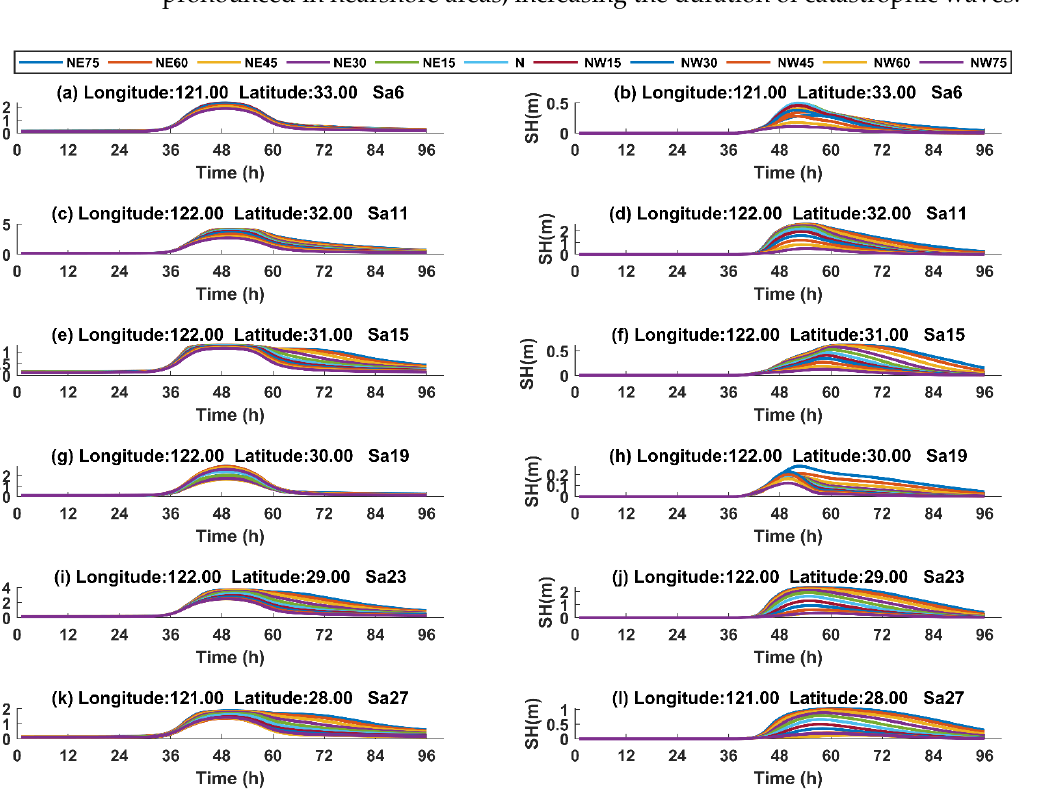
Figure 12. Time series of SWH and swell height at ( a , b ) exception station (The difference of appearance time of MSH and the maximum wind speed was unacceptable) Sa6, ( c , d ) exception station Sa11, ( e , f ) exception station Sa15, ( g , h ) exception station Sa19, ( i , j ) exception station Sa23, ( k , l ) exception station